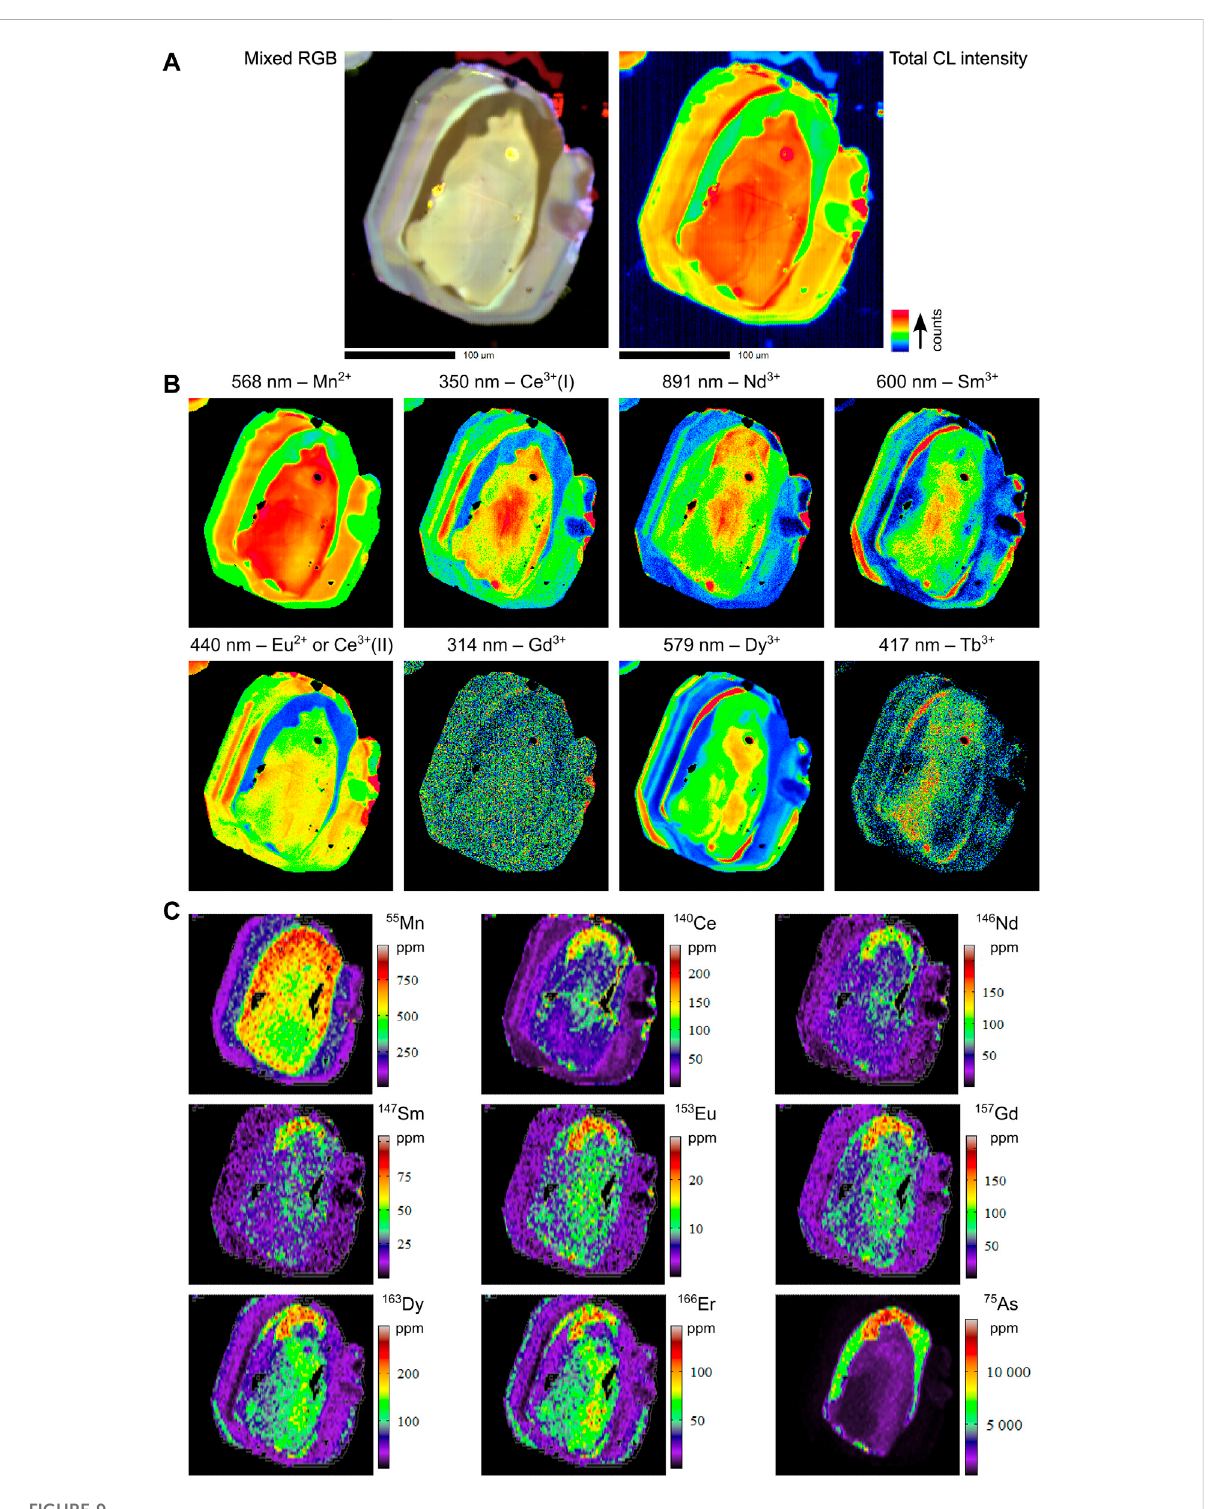
FIGURE 9 Combined hyperspectral CL and LA-ICPMS images of selected elements for sample MS_EHM92. (A) Total CL intensity and mixed RGB images. (B) Hyperspectral CL images. Note that in this sample no peak was detected for Er 3+ at 540 nm, but Tb 3+ peaks were identi fi ed, hence the strongest map for the strongest Tb 3+ peak at 417 nm is shown here instead of the 540 nm Er 3+ map. (C) LA-ICPMS images.